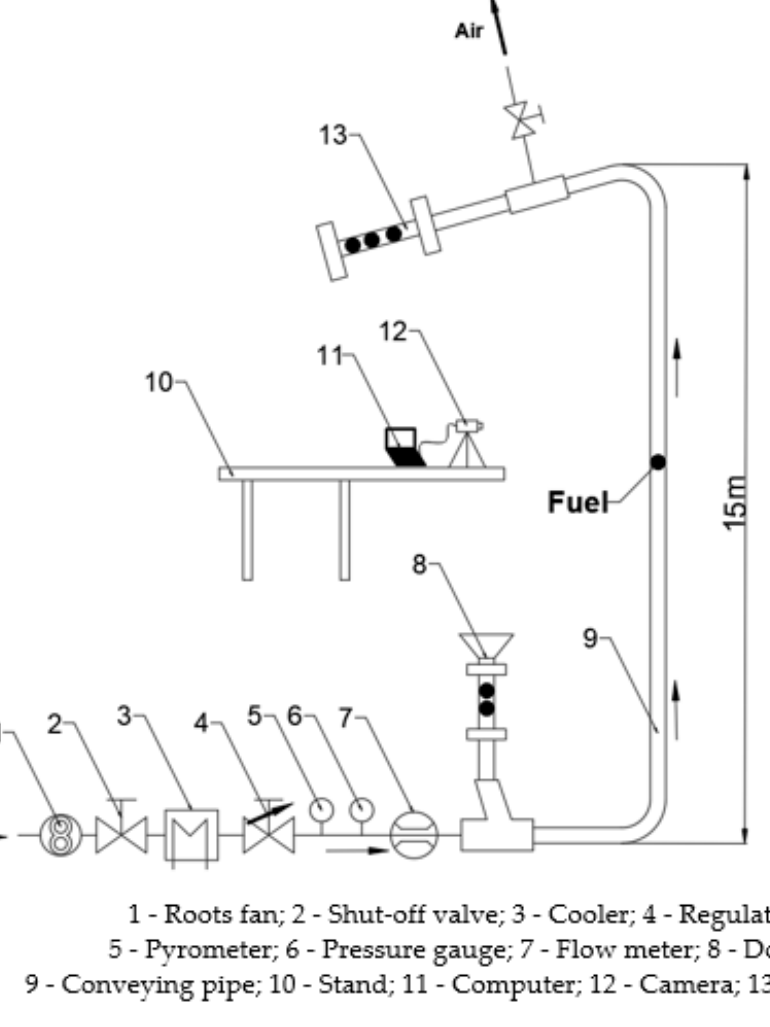
Figure 10. Schematic diagram of the test system.